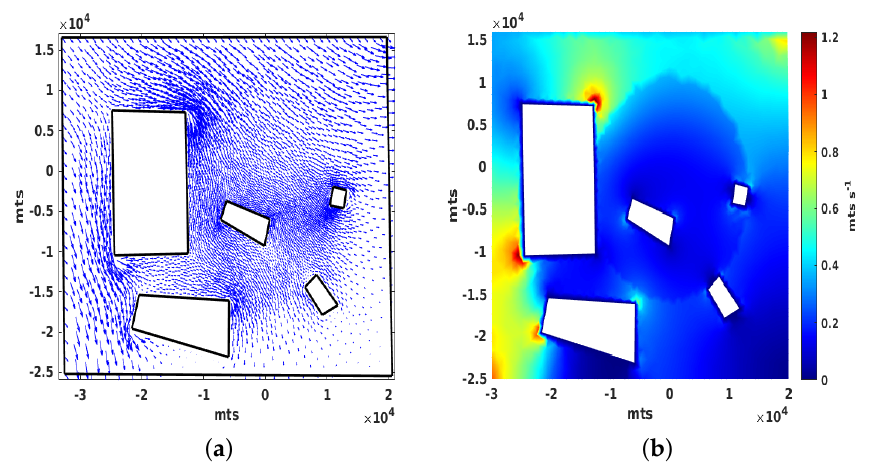
Figure 5. The reference wind field used in the experiment was constant and computed from the momentum equation. ( a ) Wind field. ( b ) Norm of the wind field (cid:107) u (cid:107)